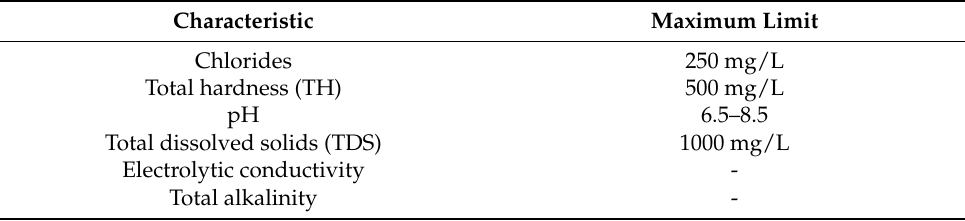
Table 3. Maximum permissible limits of